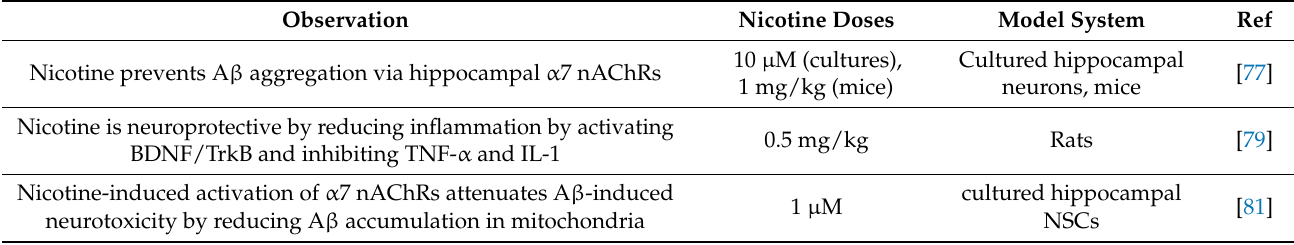
Table 3. Nicotine-related neuroprotection and neurotoxicity in